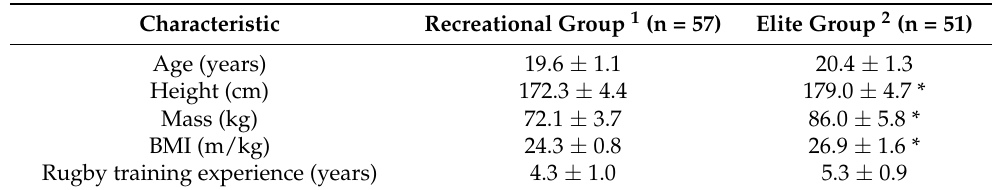
Table 1. Anthropometric characteristics of the